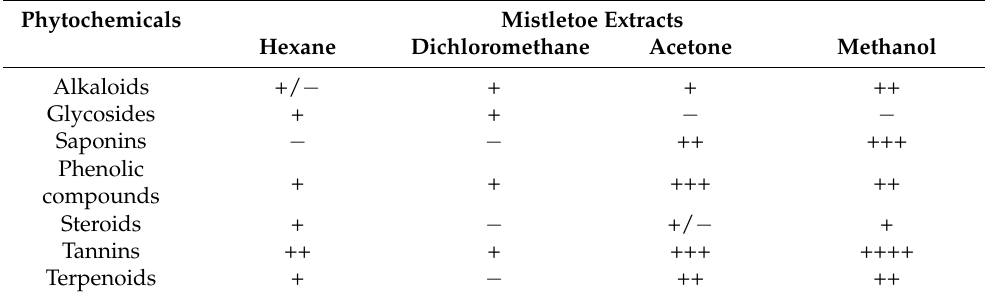
Table 1. Qualitative phytochemical present or absent in extracts of the South African Mistletoe tree.